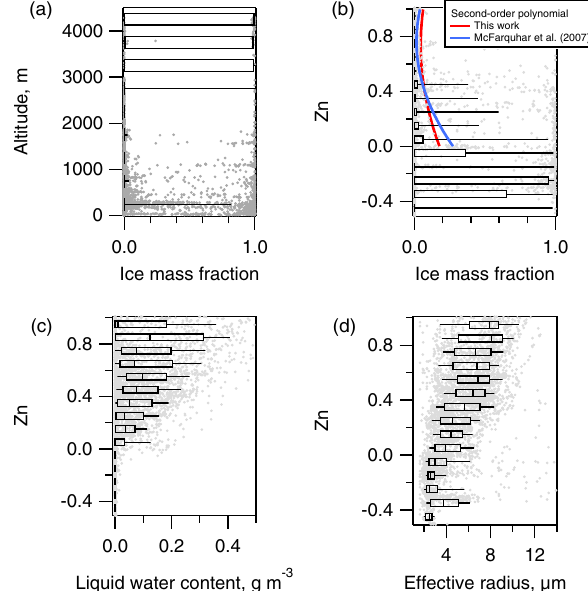
Figure 3. (a) Ice mass fraction as a function of altitude and (b) nor- malised position within the cloud (Zn). Panels (c) and (d) show sim- ilar plots for liquid water content and effective radius from the CAS probe. Boxes are the 25th and 75th percentiles; the whiskers are the 10th and 90th percentiles.